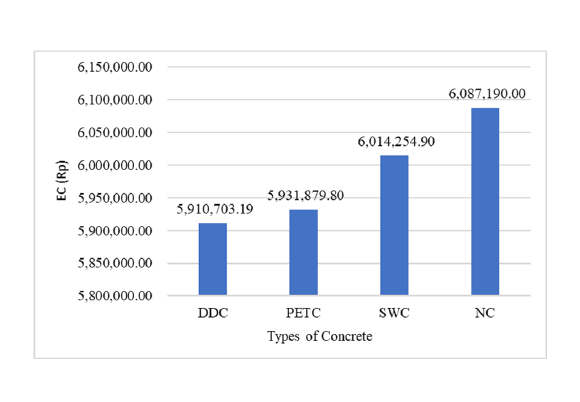
Fig. 8. Comparison of EC Value for 1 m 3